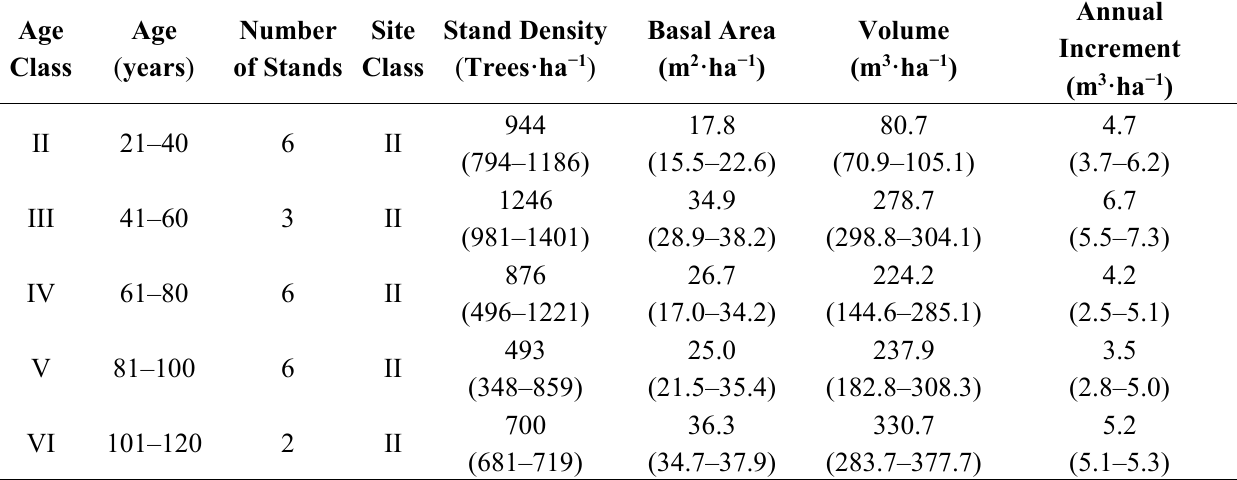
Table 1. The average values and ranges (in brackets) of basic stand structural parameters of 23 stands (subcompartments) grouped in age classes obtained from valid Forest management